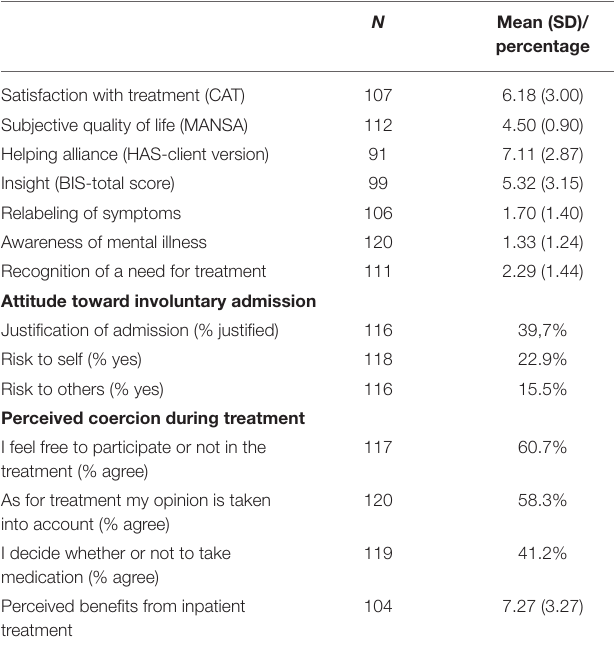
TABLE 2 | Distribution of treatment satisfaction, subjective quality of life and determinants